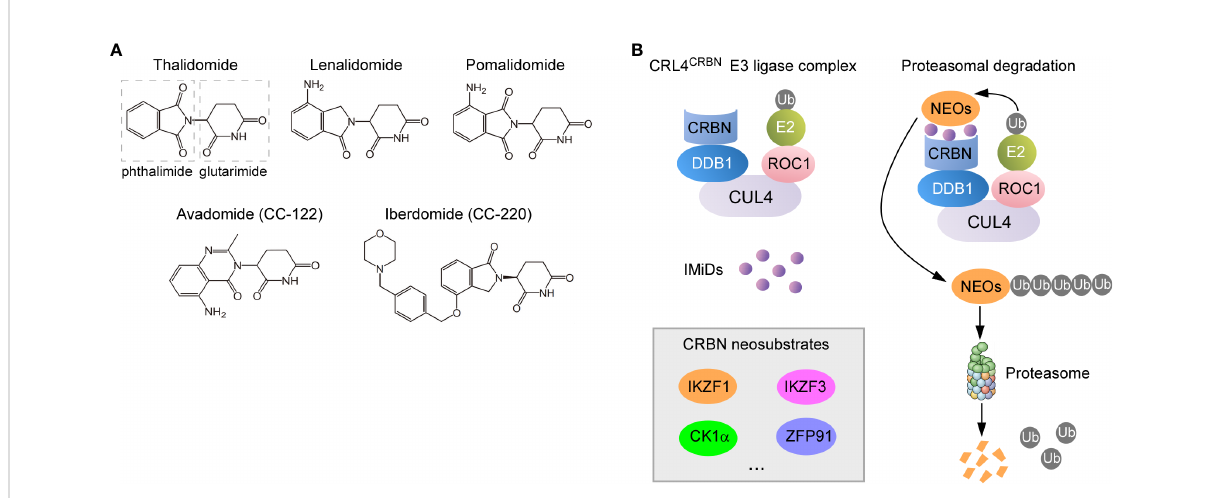
FIGURE 1 Molecular mechanisms of action for IMiDs. (A) Structure of thalidomide and its analogues. They all share a glutarimide ring that binds to CRBN while vary in the neosubstrate-binding moiety (phthaloyl ring). (B) Proteasomal degradation of CRBN neosubstrates redirected by IMiDs. IMiDs act as the molecular glue to recruit neosubstrate proteins to CRBN receptor component of the CRL4 CRBN E3 ligase complex (left), which leads to the sequential ubiquitylation and degradation of neosubstrates (NEOs)